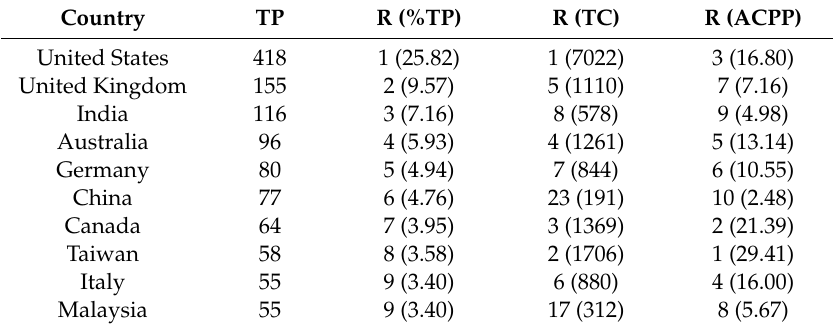
Table 2. Top ten most productive countries in the field of Green product research.